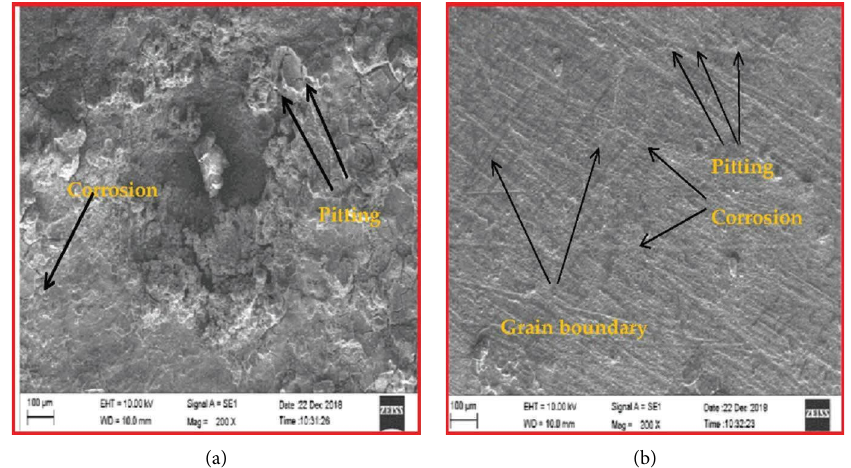
2 O 3 -wt% SiC composites. Adapted with permission from Ref.